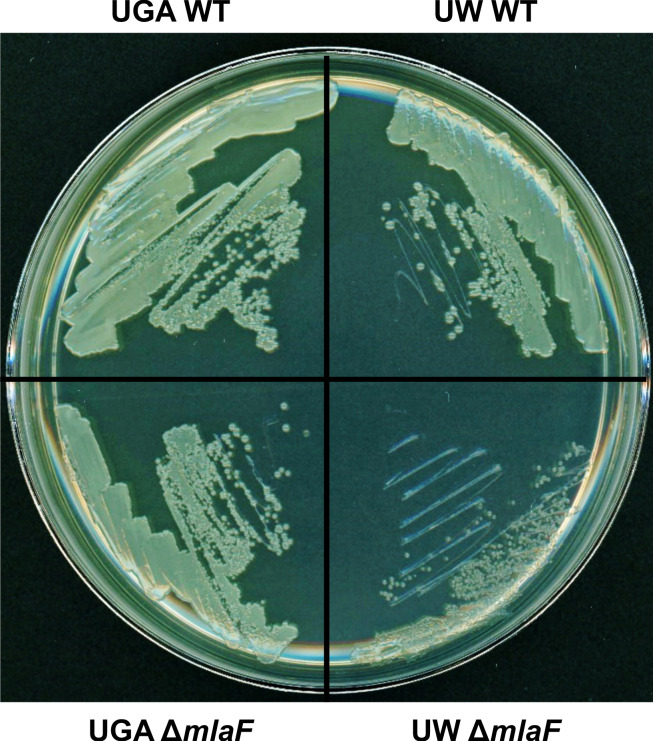
UW ΔmlaF has a distinct colony morphology.Top left – UGA WT grown on LB + 1.5% agar. Bottom left – UGA ΔmlaF. Top right – UW WT. Bottom right – UW ΔmlaF.